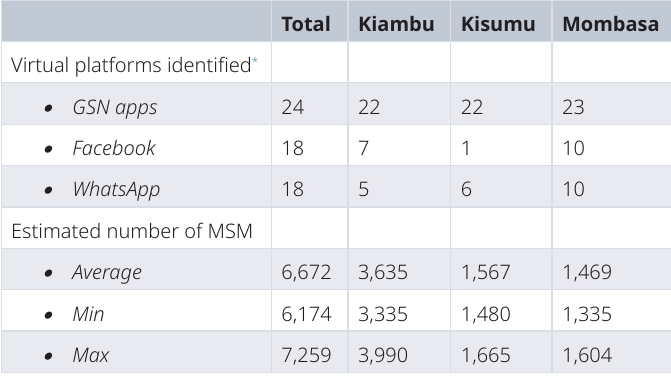
Table 2. Estimated number of MSM operating through virtual platforms in selected counties in Kenya,